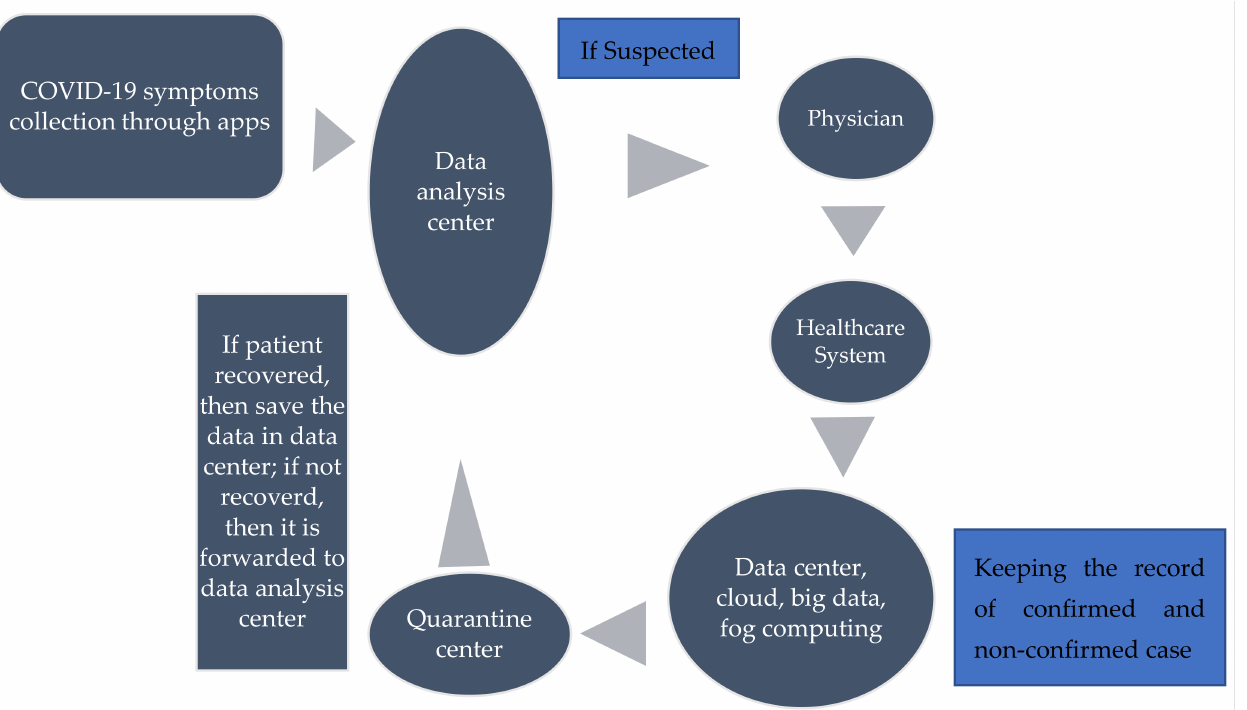
Figure 8. Structure diagram of the IOT healthcare system during COVID-19. Table 1. Applications and